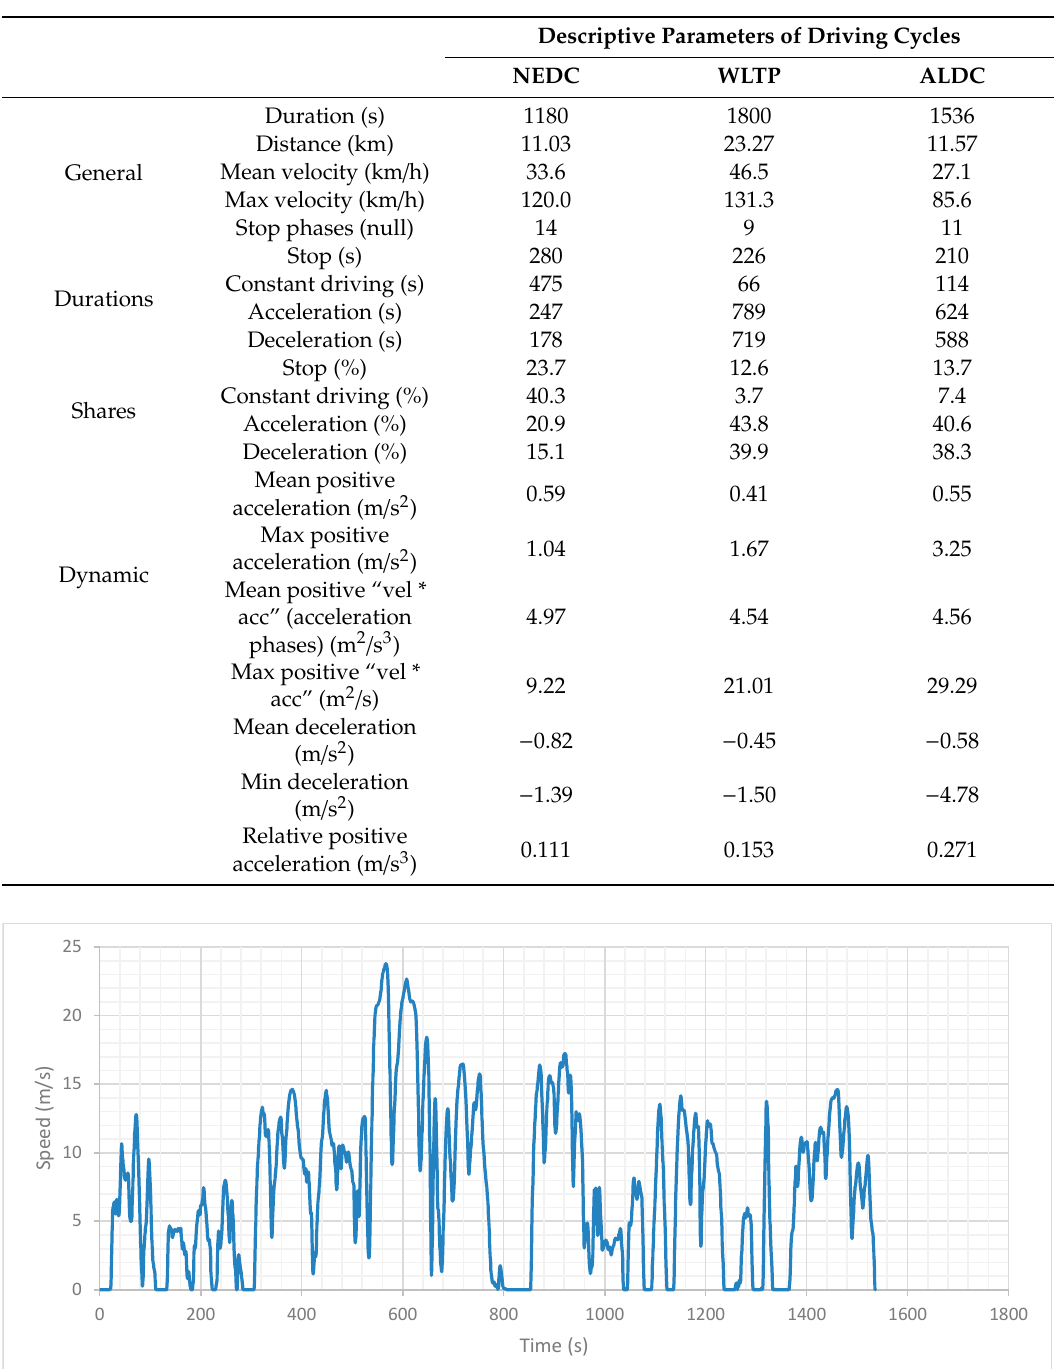
Table A2. Main descriptive parameters for the considered drive cycles.